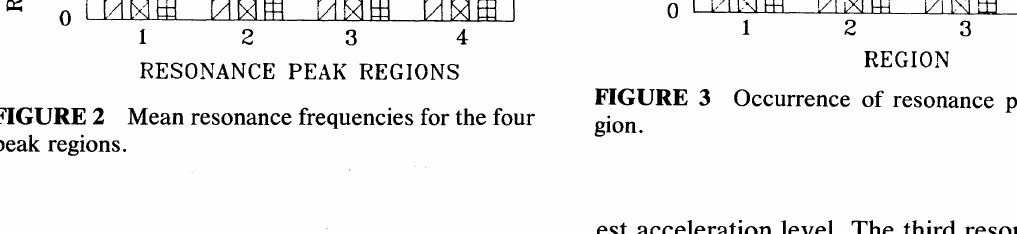
FIGURE 3 Occurrence of resonance peaks by re- gion.